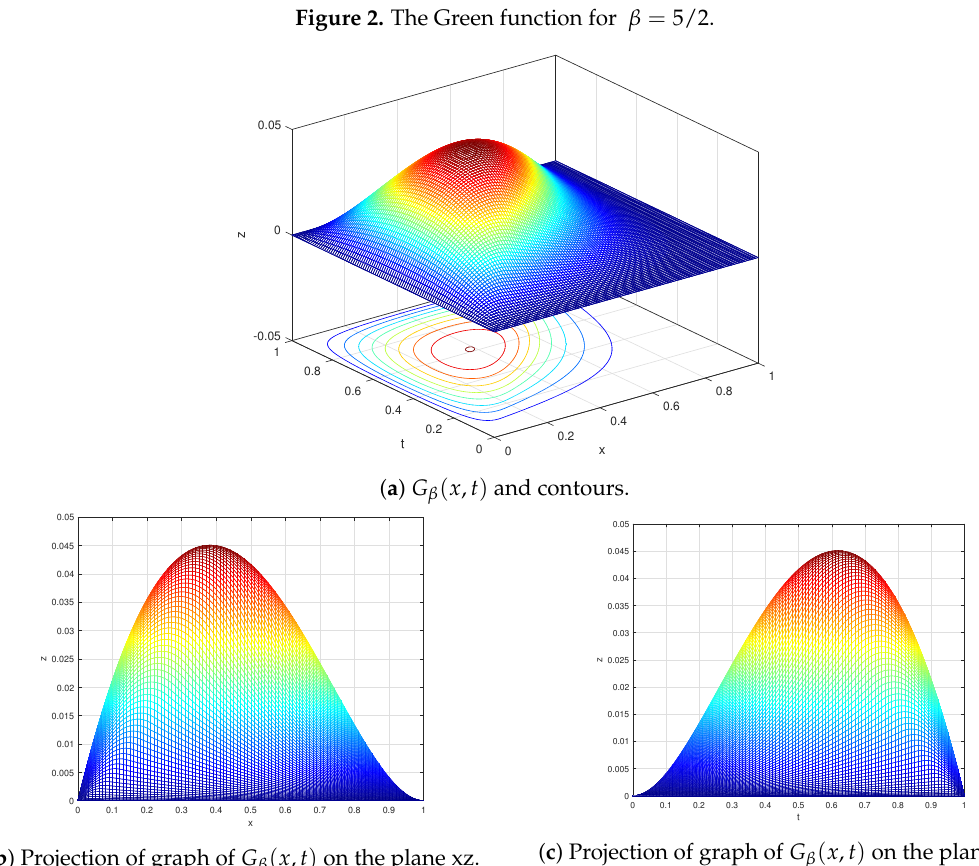
( b ) Projection of graph of G β ( x , t ) on the plane xz. ( c ) Projection of graph of G β ( x , t ) on the plane tz. Figure 3. The Green function for β =